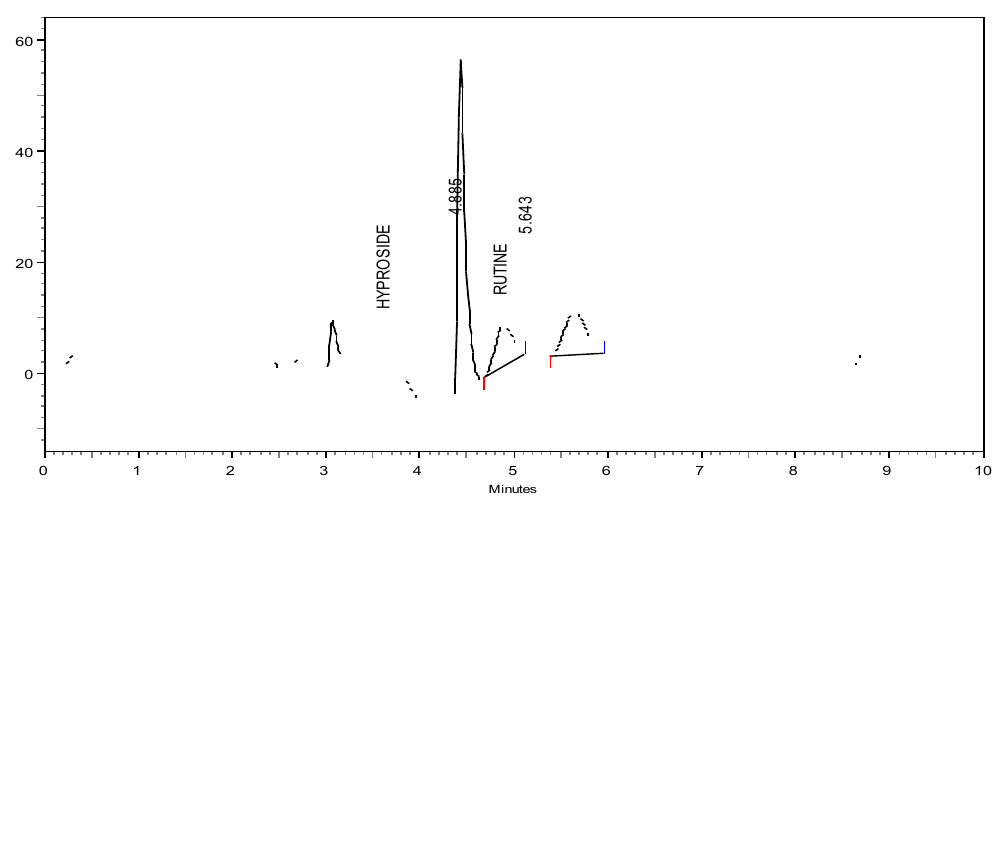
Figure 5. HPLC chromatographs of